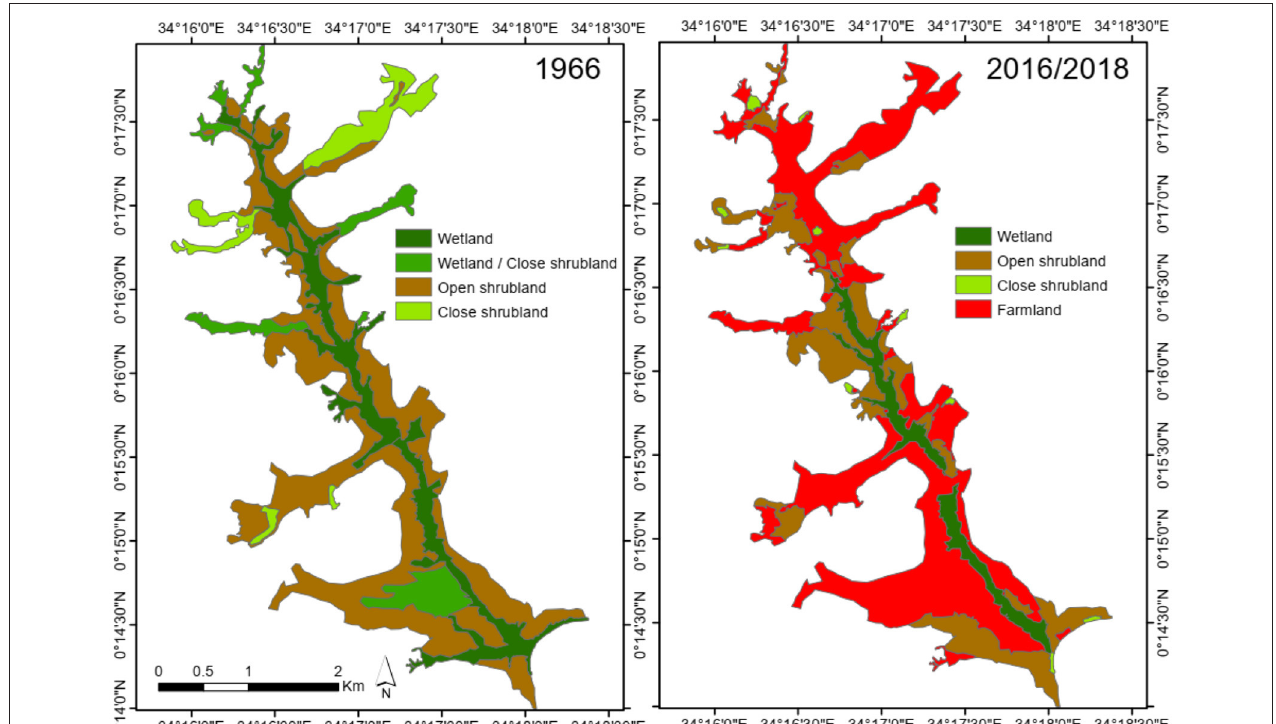
FIGURE 3 | Land use/cover maps of Anyiko wetland and its surrounding in 1966 and 2016/2018.